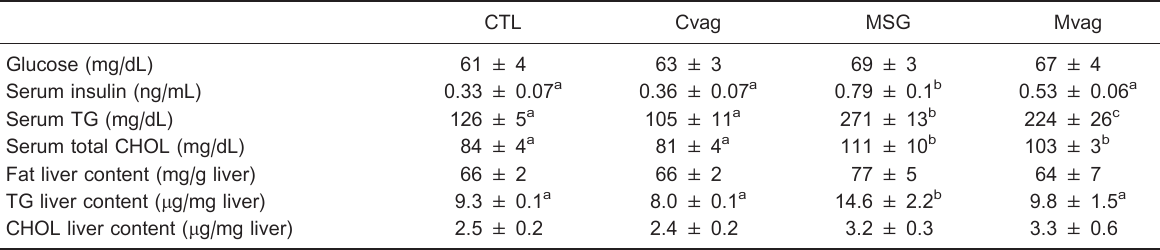
Table 2. Fasting serum glucose, insulin, TG and total CHOL concentrations and total fat, TG and CHOL content in the liver of 90-day- old CTL, Cvag, MSG and Mvag rats.